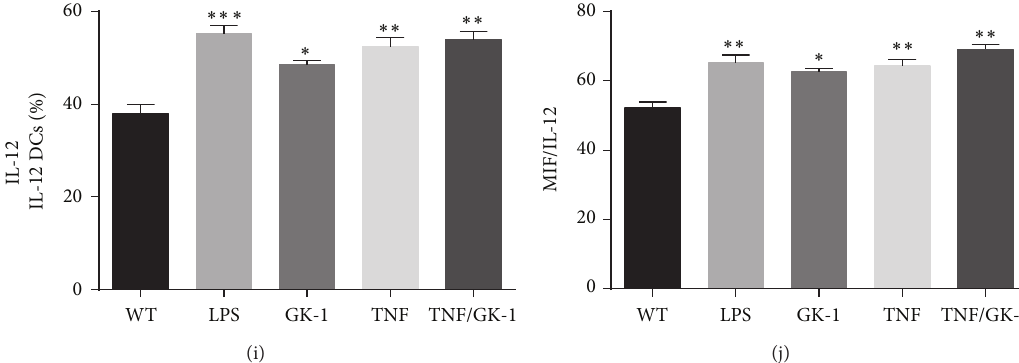
Figure 1: BMDCs phenotype. Levels of molecules of the major histocompatibility complex II (MHCII), CD40, CD80, CD86, and IL-12 in BMDCs were measured after different treatments: control (without treatment: WT), LPS, GK-1, TNF 𝛼 , TNF 𝛼 /GK-1. Treatment with LPS, TNF 𝛼 , and TNF 𝛼 /GK-1 induces increased expression of MHCII, CD40, CD80, and CD86. When BMDCs were treated only with GK-1 an increase in the production of IL-12 was found. (a) Mean fluorescence intensity (MIF) of MHCII. ∗ 𝑃 < 0.05 , ∗∗∗ 𝑃 < 0.001 . (b) BMDCs phenotype after 10 days of differentiation. 91.9% differentiation was induced (91.9% of CD11c+ cells). Red: isotype control. Blue: BMDCs. (c) Percentage of CD40+ BMDCs after treatment. ∗ 𝑃 < 0.05 . (d). MFI of CD40 in BMDCs. ∗∗ 𝑃 < 0.001 , ∗∗∗ 𝑃 < 0.0001 . (e) Percentage of CD86+ BMDCs. ∗ 𝑃 < 0.05 , ∗∗ 𝑃 < 0.001 . (f) MFI of CD86 in BMDCs. ∗ 𝑃 < 0.05 , ∗∗ 𝑃 < 0.001 , c 𝑃 < 0.05 TNF 𝛼 versus GK-1. (g) Percentage of CD80+ BMDCs. ∗ 𝑃 < 0.05 . (h) MFI of CD80 in BMDCs. ANOVA, Tukey. ∗∗∗ 𝑃 < 0.0001 , c 𝑃 < 0.0001 TNF/GK-1 versus GK-1, + 𝑃 <